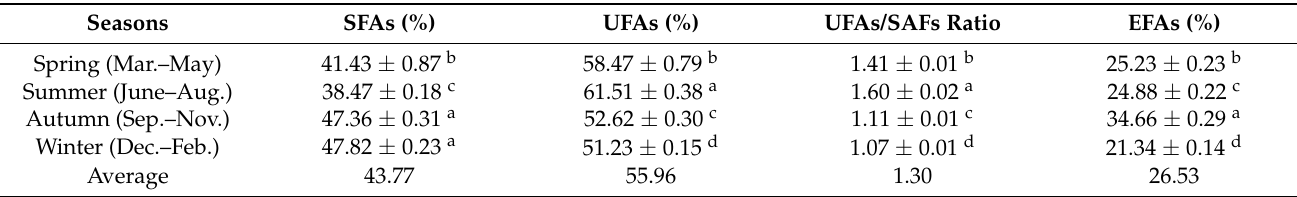
Table 3. Saturated (SFAs), unsaturated (UFAs), and essential fatty acids (EFAs) of honeybee pollen loads harvested from the Al-Ahsa oasis.